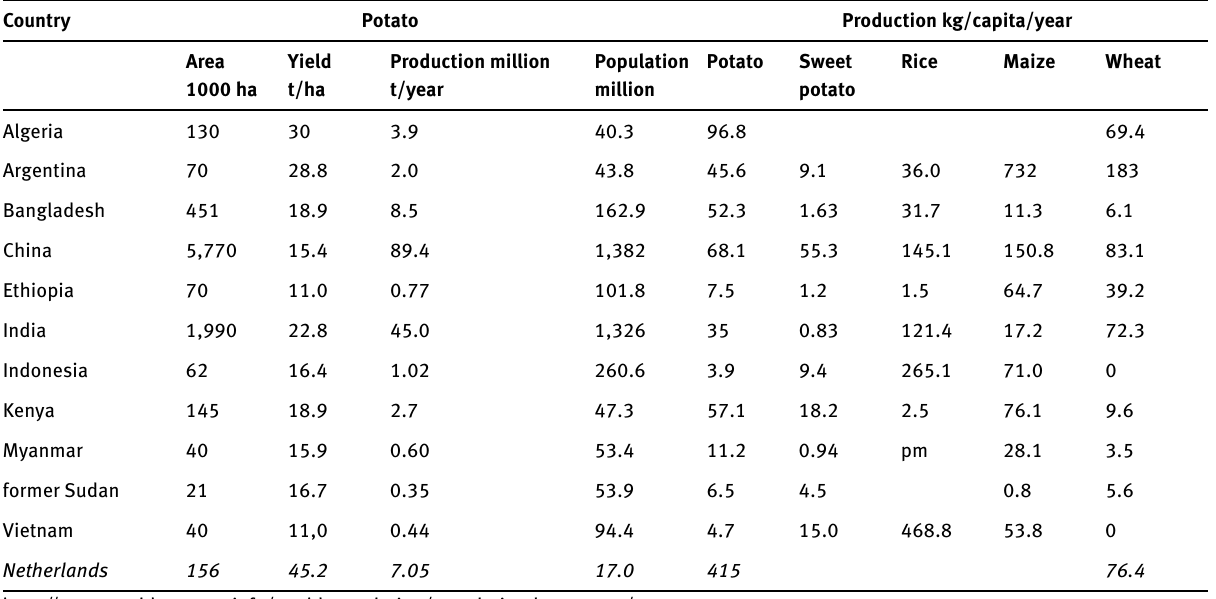
Table 1: Selected data from the PPP target and reference countries, data from FaoStat (2016), Worldometer (2016) Country